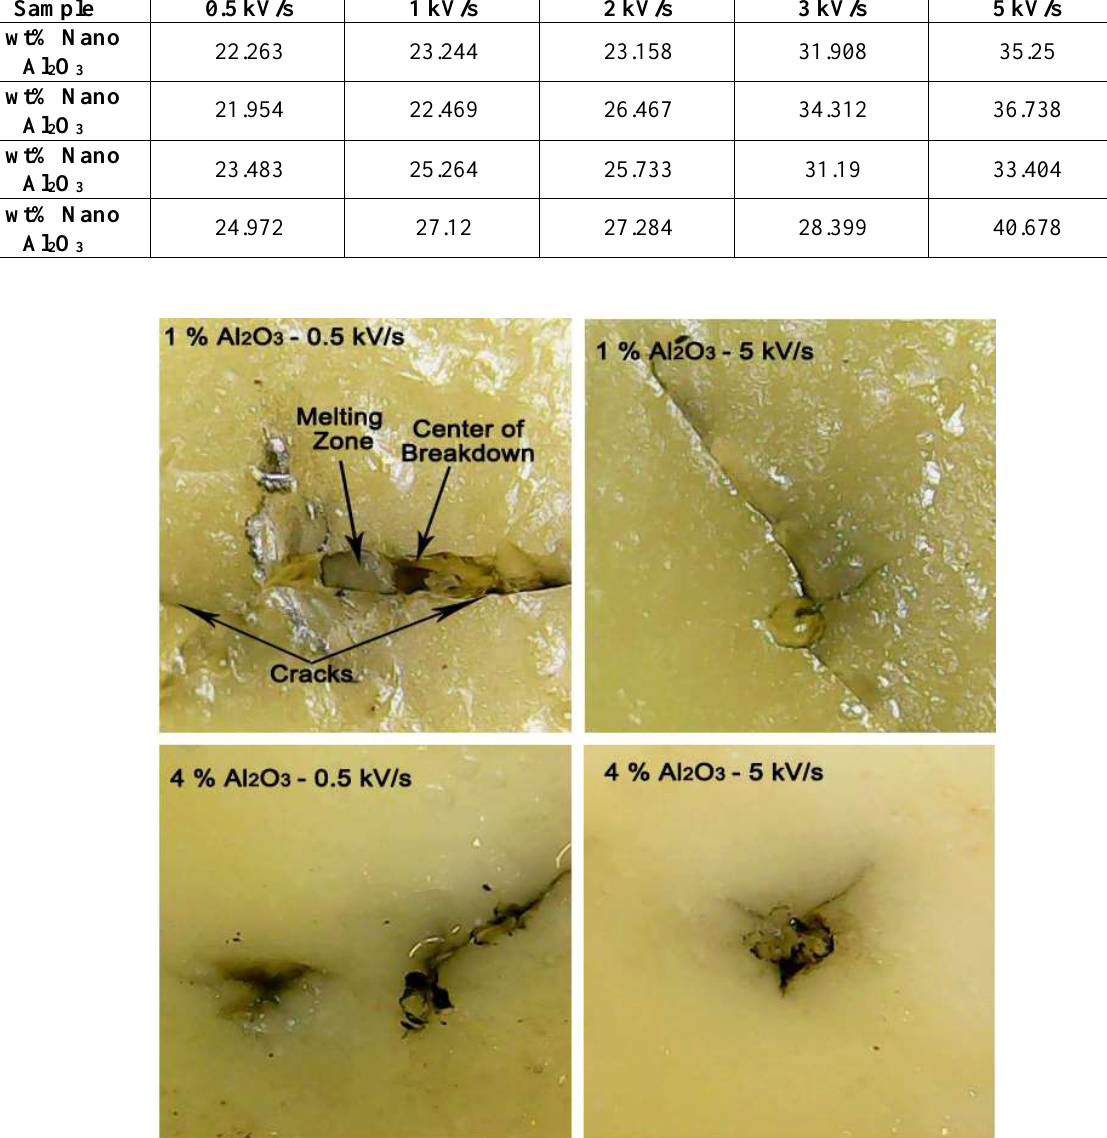
Figure 7: Trace of electrical breakdown damage for 1%Al 2 O 3 and 4% Al 2 O 3 with 0.5, 5